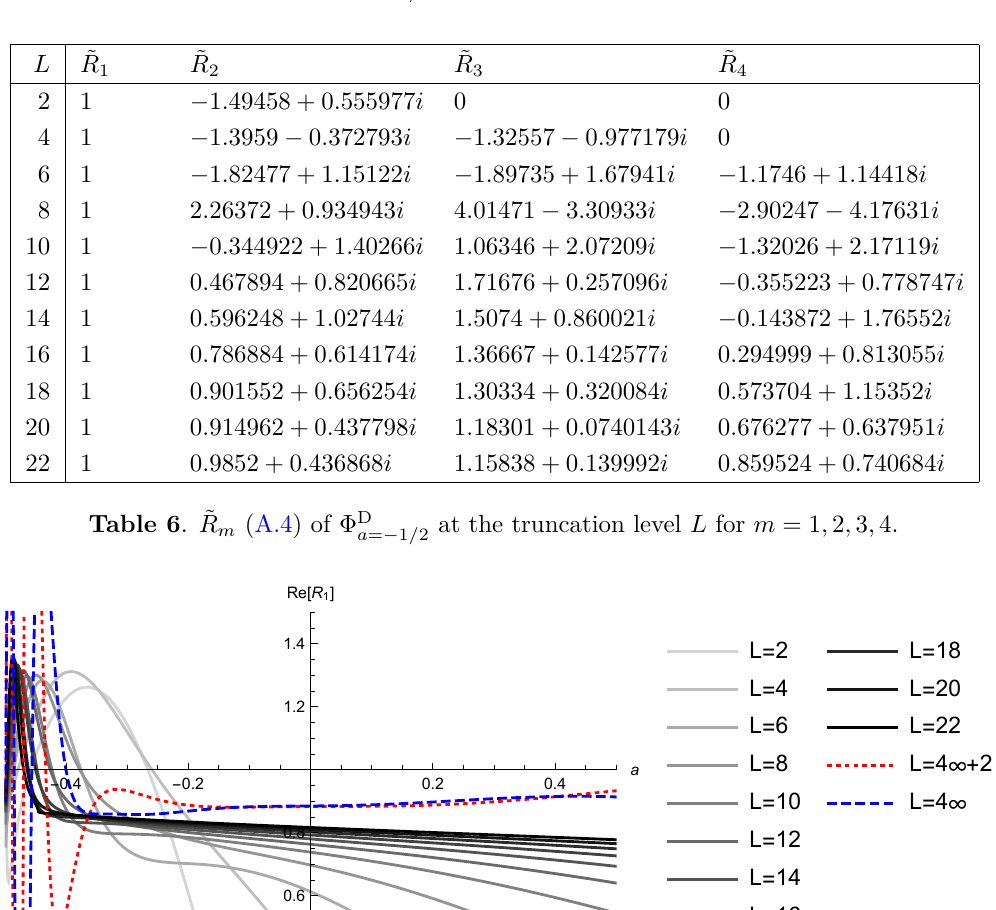
Table 5 . R m (A.3) of Φ D at the truncation level L for m = 1 , 2 , 3 , 4 . a = − 1 / 2